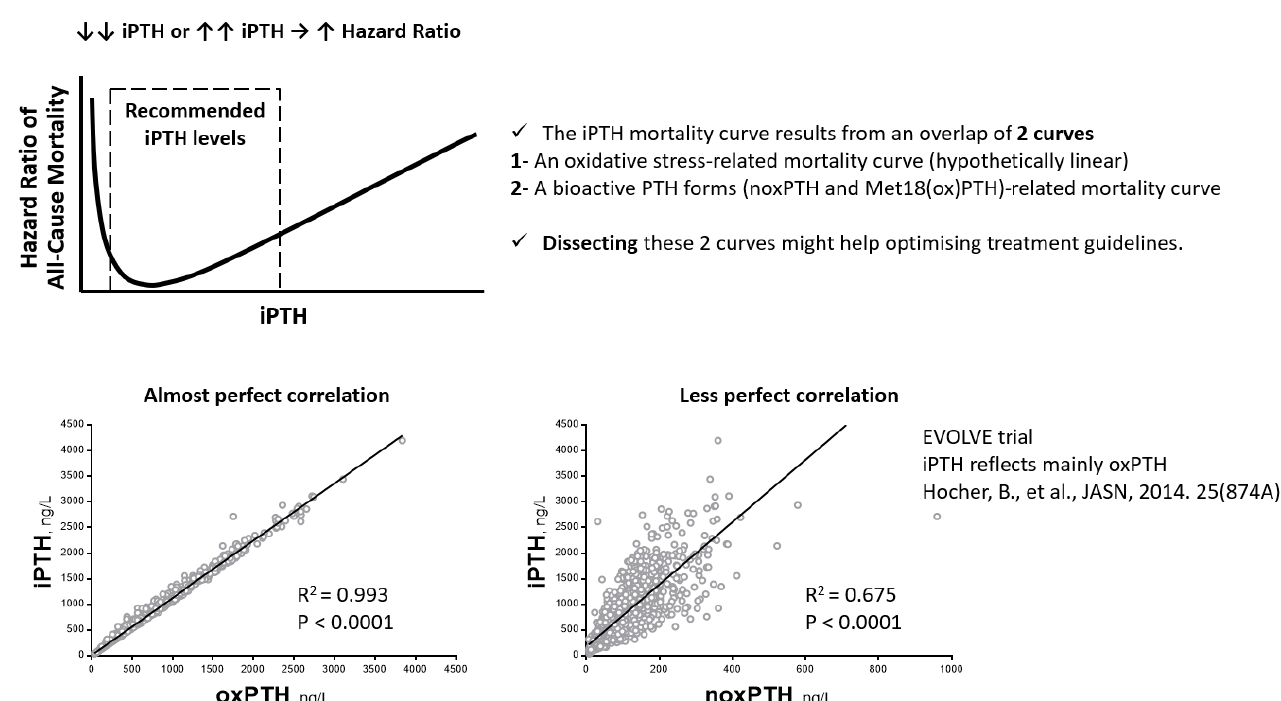
Figure 4. All-cause mortality curve of iPTH and its correlation with oxPTH and noxPTH. The U- shaped association is derived from the following publications: [50–54], and the correlation data are derived from the EVOLVE trial [45]. Other smaller studies [41,48] showed comparable correlations too. PTH = parathyroid hormone; oxPTH = oxidized PTH; noxPTH = non-oxidized PTH; Met18(ox)PTH: PTH oxidized at Met